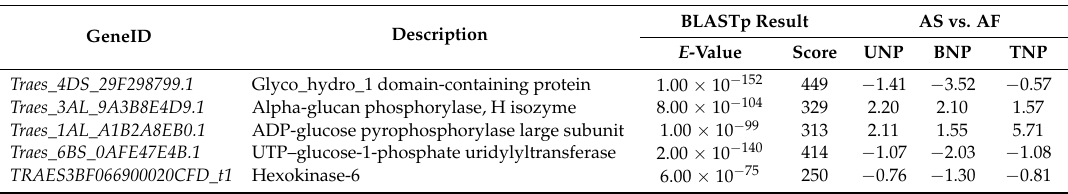
Table 2. Differentially abundant proteins related to starch and sucrose metabolism in fertile and sterile plants. GeneID